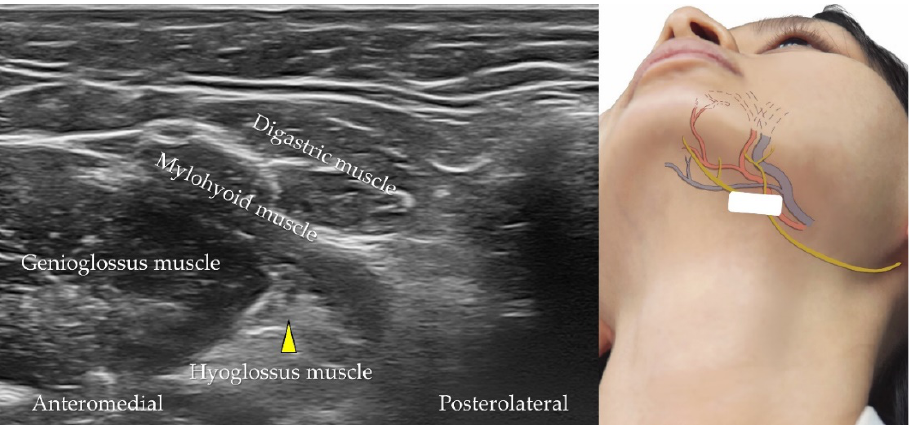
Figure 22. Ultrasound imaging of the hypoglossal nerve (yellow arrowhead) . White square , footprint of the ultrasound transducer.